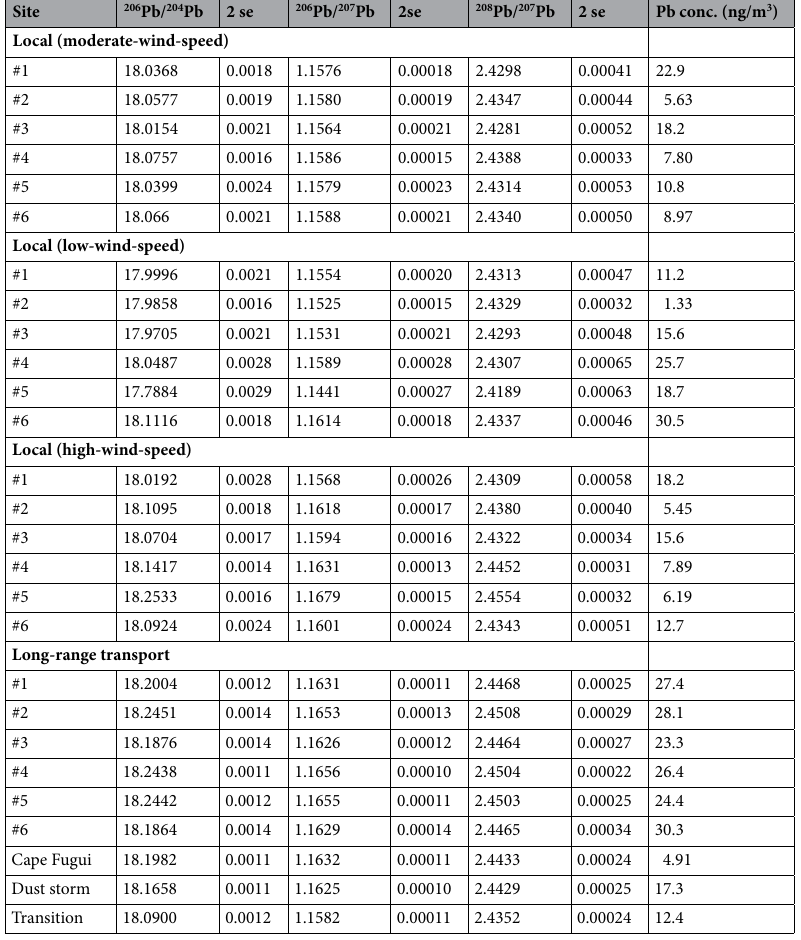
Table 3. Pb concentration and Pb isotope ratios of PM 10 samples collected during each event type in central